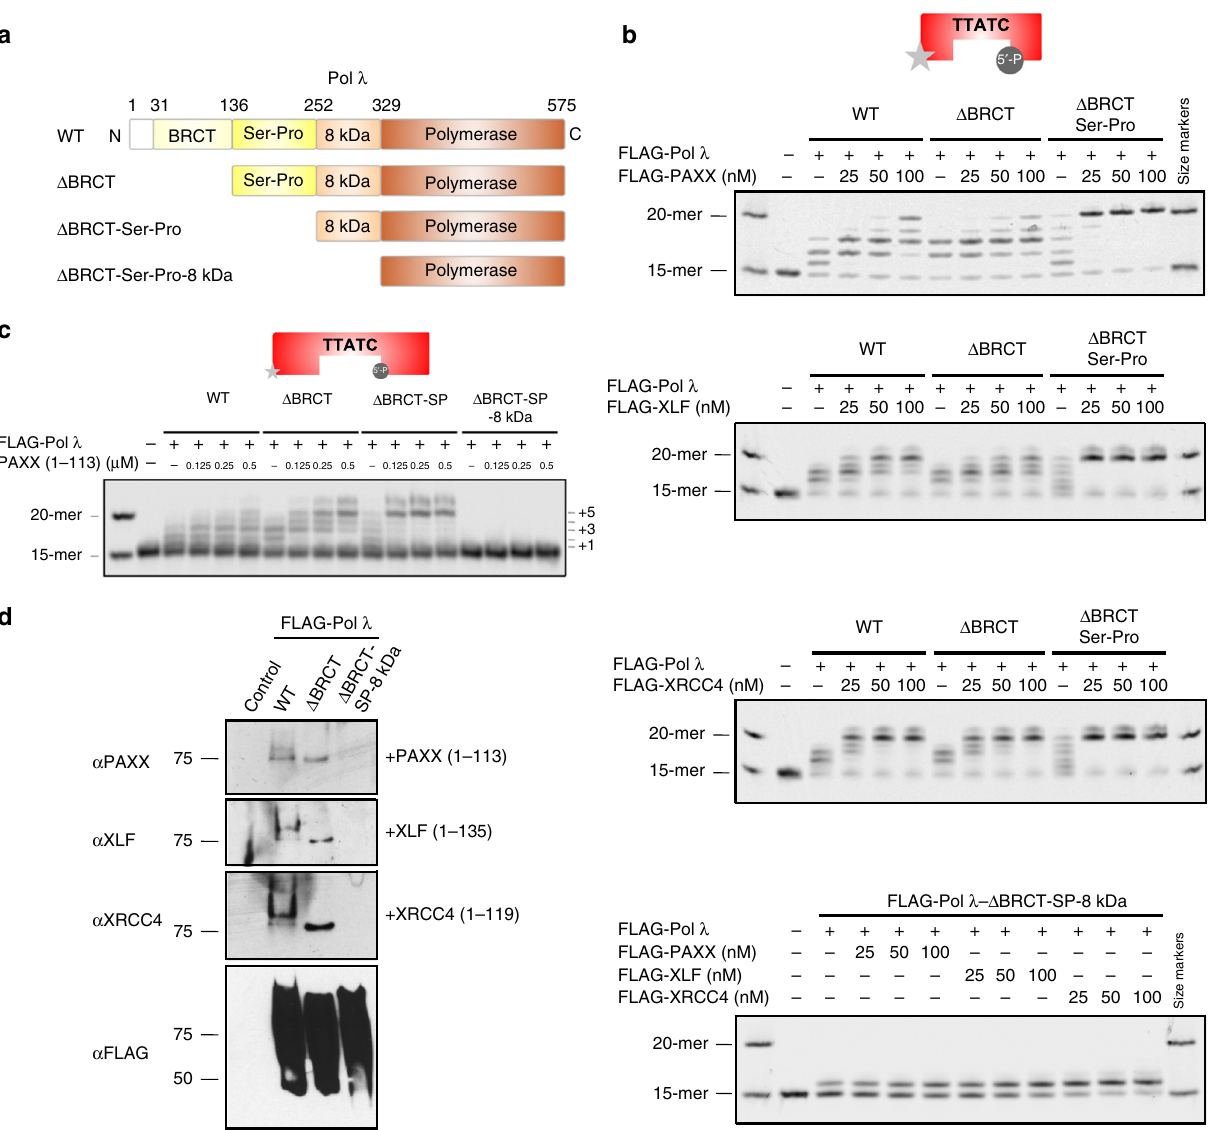
Fig. 8 The Pol λ 8 kDa domain is required for stimulation of Pol λ -dependent gap fi lling activity via interaction with the head domain of XRCC4 family proteins. a Schematic representation of N-terminal Pol λ deletion mutants. b PAXX, XLF and XRCC4 stimulate gap fi lling synthesis activity of Δ BRCT- and Δ BRCT-Ser-Pro-Pol λ but not Δ BRCT-Ser-Pro-8kDa-Pol λ with an IRDye ® 700-labelled 5nt-gapped dsDNA (33-mer) substrate. c PAXX head domain promotes gap fi lling synthesis activity of Δ BRCT- and Δ BRCT-Ser-Pro-Pol λ but not Δ BRCT-Ser-Pro-8kDa-Pol λ . d Far-Western blot analysis showing that the head domain of XRCC4 family proteins interacts with Pol λ -WT and - Δ BRCT but not - Δ